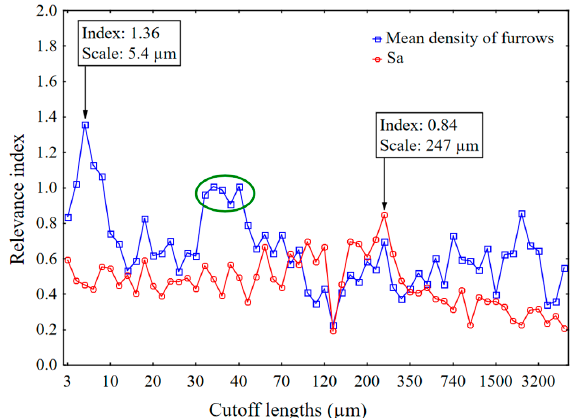
Figure 10. Classification rankings by relevance indices for discrimination of the seven materials by 75 topographic parameters for 100 bootstraps.